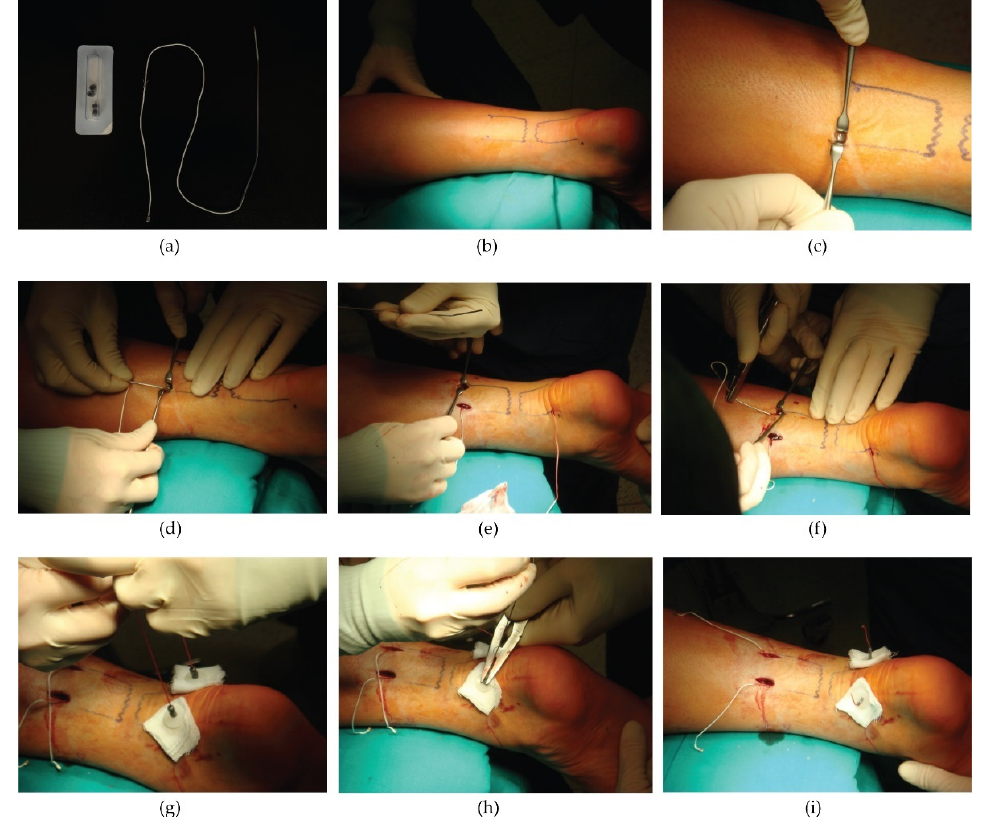
Figure 3. The Tenolig surgical technique. ( a ) The Tenolig device and its components. ( b ) During surgery, the tendon rupture point is marked. ( c ) The first small skin incision (<1 cm) is performed approximately 6 cm above the rupture zone. ( d ) The first needle is inserted taking care to allow the anchor to penetrate perpendicularly into the proximal side of the tendon and then remove it from the distal portion of the tendon, 4 or 5 cm below the rupture point. ( e ) The second incision is made, and ( f ) the same procedure is repeated with the second needle. At the end, both needles are cut. ( g ) The plastic buttons are applied to protect the skin. The two straps are pulled tight simultaneously while the ankle is maintained in equinus position, ( h ) and the weights are threaded to fix the straps distally. ( i ) The sutures of the skin are left long to allow the removal of the implant 45 days after surgery.